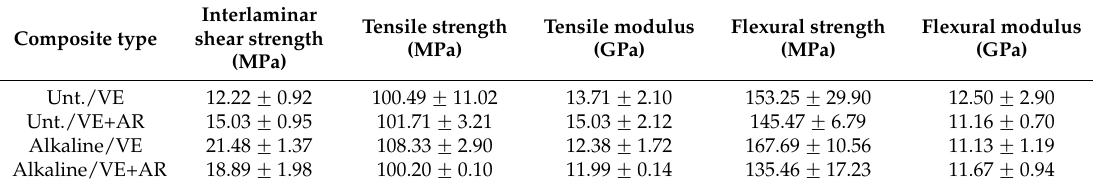
Table 3. Results of mechanical tests for untreated and treated flax fiber with VE and VE+AR resins (raw data). Composite type